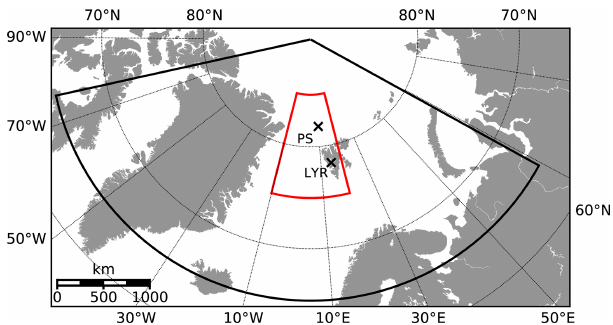
Figure 1. Setup of the limited-area simulations. The outer domain (black) has an approximate resolution of 2.4km, while the inner domain (red) has a resolution of 1.2km. Additionally marked is Longyearbyen (LYR, Norway) where Polar 5 and Polar 6 were sta- tioned during ACLOUD, as well as the position of R/V Polarstern (PS) during the ice floe camp